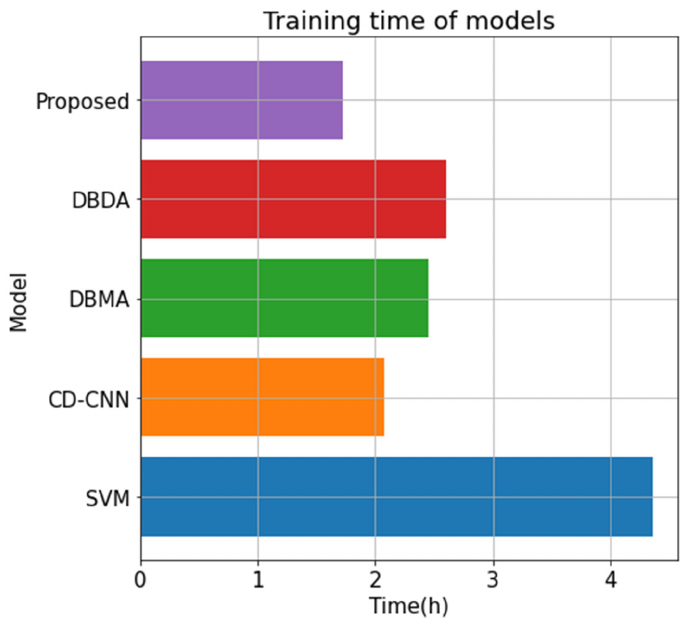
Figure 5. Training time.